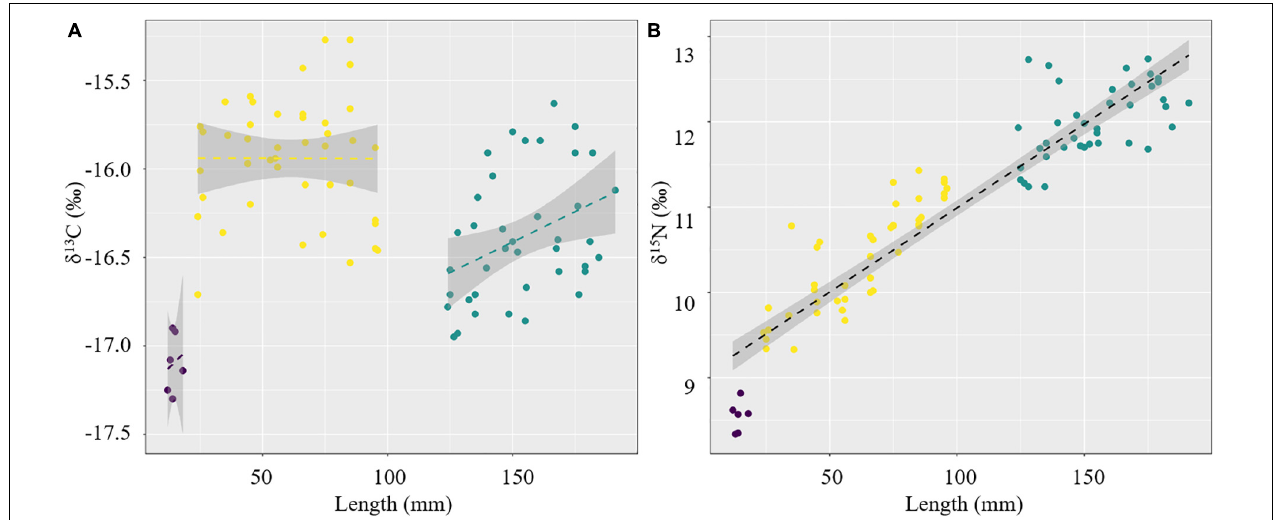
FIGURE 3 | Regression analysis between δ 13 C (A) and δ 15 N (B) with a mantle length of S. esculenta.